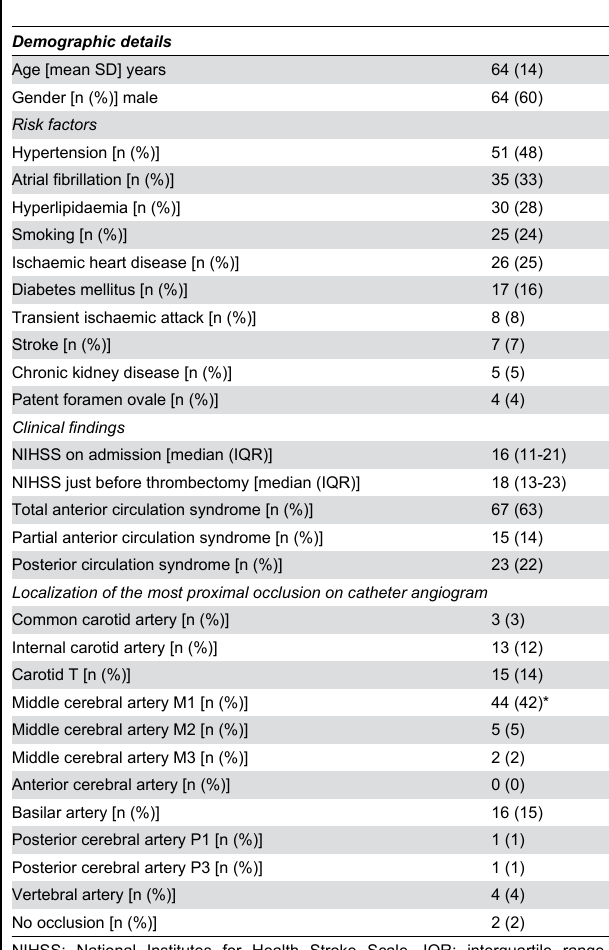
Table 1. Baseline characteristics of